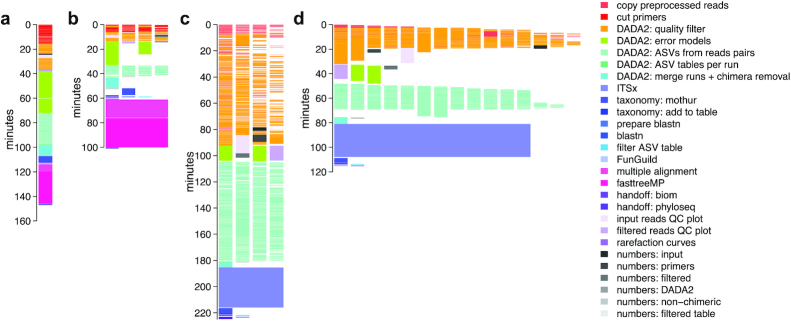
Visualization of resource use by processing different datasets. (a) The small (24 sample) 16S rRNA V4 amplicon dataset [42] processed linearly on a single core; (b) the same dataset processed on up to 4 cores (each depicted as a vertical stack); (c) a medium-sized (267 sample) ITS1 amplicon dataset [43], processed on up to 4 cores; (d) the same dataset, processed on up to 15 cores. Each block represents 1 job issued by dadasnake; colours represent the respective steps. QC: quality control.